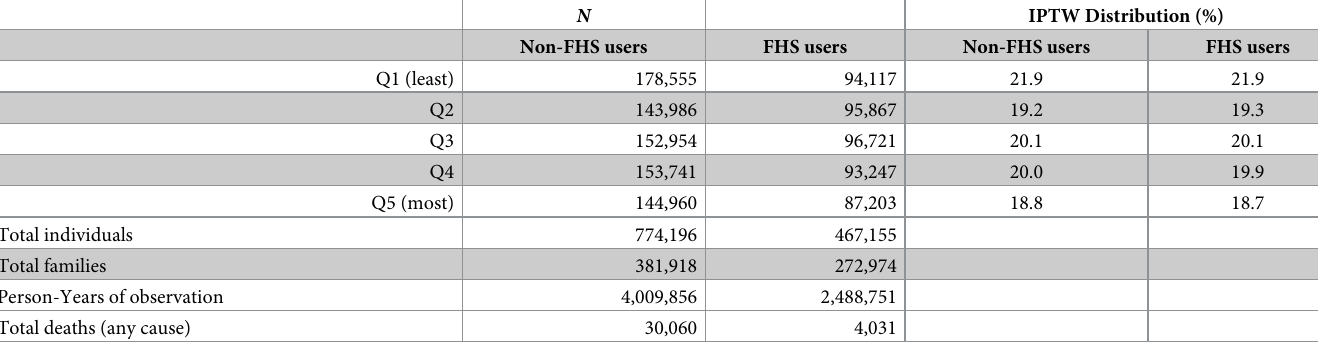
of death was higher for individuals who were male (compared with female); who self-classified as black, pardo , or other racial groups (compared with white); who were disabled (compared with no reported disability); who were informally employed (compared with formally employed); who had any prior hospitalizations (compared with no hospitalizations); and who were in households receiving a conditional cash transfer (compared with those that did not). There was a gradient of increasing HRs across age groups and a decreasing gradient HRs across educational groups (the lowest HRs for those with the highest educational attainment), household income groups (lowest HRs for the highest income groups), and household food expenditure quintiles (lowest HRs for the highest expenditure group). Time- and utilization- varying analyses revealed the largest reductions in hazard of death were found for those who had been FHS users for at least 1 year (Fig 2) and who had 3 or more consultations over the period (see S8 Table and S4